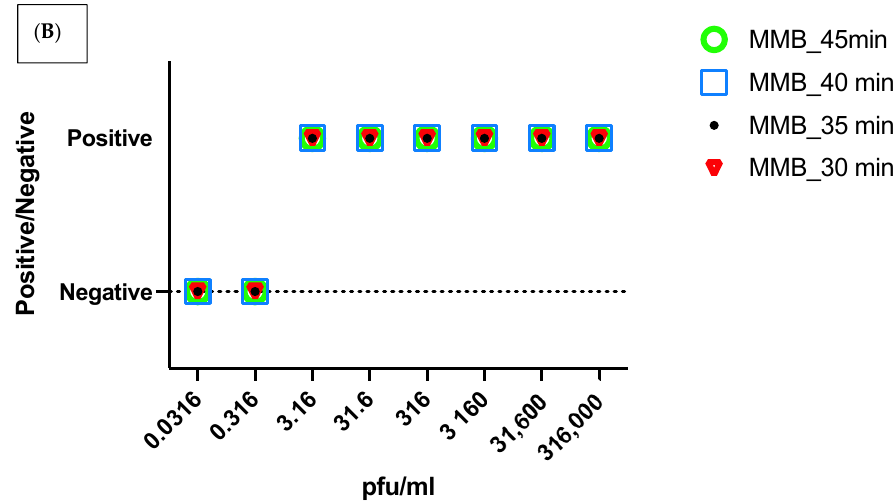
Figure 2. The LOD of MMix-A ( A ) and MMix-B ( B ) was evaluated at 60- 45- 40-, 35- and 30-min using cell culture isolates. The shortest time to give the highest level of detection (3.16 pfu/mL) for both assays was 45- and 30-min using MMix-A and MMix-B, respectively.